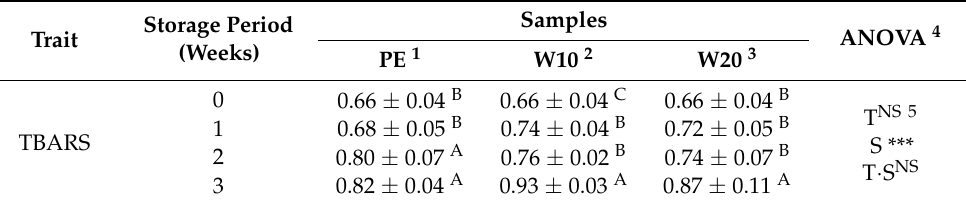
Table 2. Thiobarbituric acid reactive substance (TBARS; mg malondialdehyde/kg sample) of sausages stored in the PE and biodegradable containers manufactured with walnut shell powder. Storage Period Trait (Weeks)